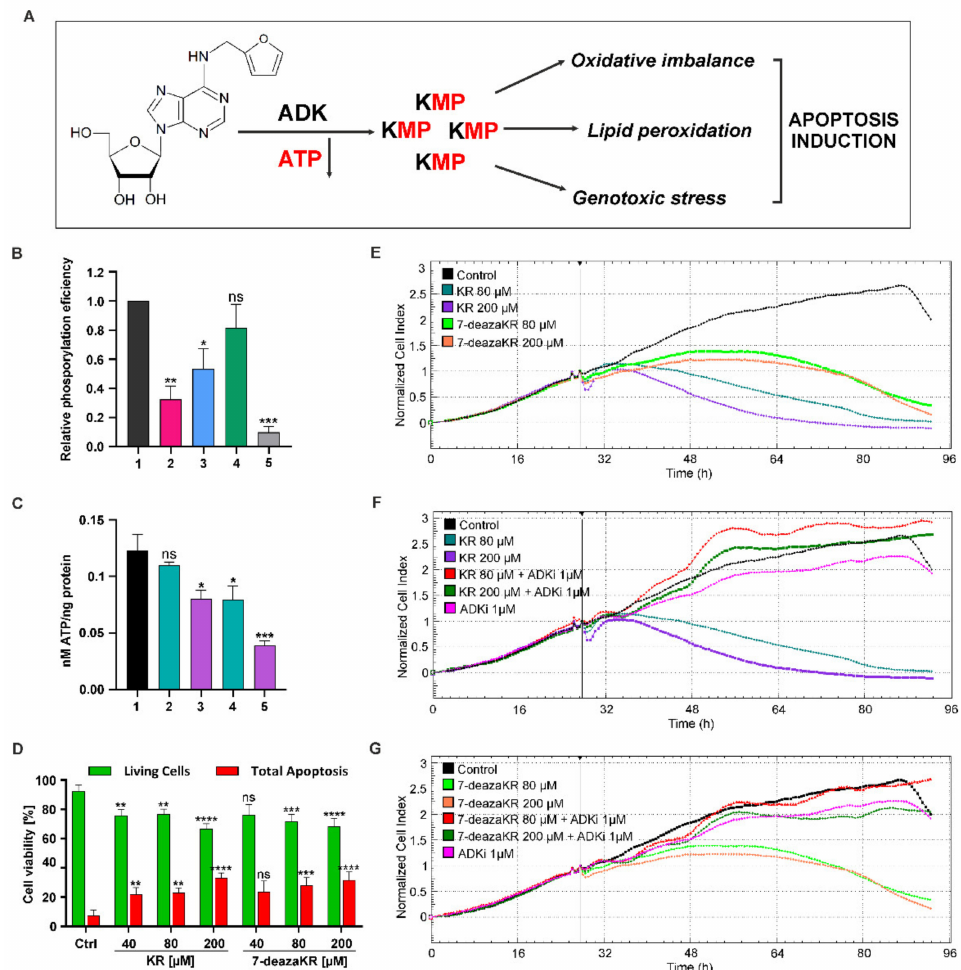
Figure 6. Kinetin riboside and 7-deazakinetin riboside activity and toxicity in T98G cells depend on ADK activity. ( A ) Phosphorylation of kinetin riboside by ADK promotes its cellular toxicity, leading to apoptosis induction. ( B ) In vitro phosphorylation of 7-azaKR (1–4 mM, bars 2–4, respectively) by ADK. The data are presented as the mean ± SD of three independent experiments. Bar 1—positive control of phosphorylation efficiency with 2 mM KR as a substrate. For the negative control, 0.5 mM 5-iodotubercidin was used as an ADK inhibitor (bar 5). ( C ) Determination of ATP level in the cells after treatment with 80 and 200 µ M KR and 7-deazaKR treatment (bars 2–5, respectively) compared to control (bar 1). The results normalized for 1 mg of protein are shown as the mean ± SD from three independent experiments. ( D ) Flow cytometry analysis of apoptosis/necrosis in T98G cells after 24 h incubation with KR and 7-deazaKR (40–200 µ M). ( E – G ) T98G real-time cell proliferation in the presence of KR and 7-deazaKR. The influence of KR and 7-deazaRK (80 and 200 µ M) on HepG2 cell proliferation ( E ) with the addition of an ADK inhibitor (1 µ M iodotubercidin; ( F , G ) was monitored by the xCELLigence system for 120 h at 30 min intervals. The results are representative of at least three independent experiments. Green bars indicate live cells, while red bars represent cells with both early and late apoptosis. The data are presented as the mean percentage ± SD from three independent experiments. Statistical significance is indicated with asterisks: (ns) p > 0.05, * p < 0.05, ** p < 0.01, *** p < 0.001, **** p <